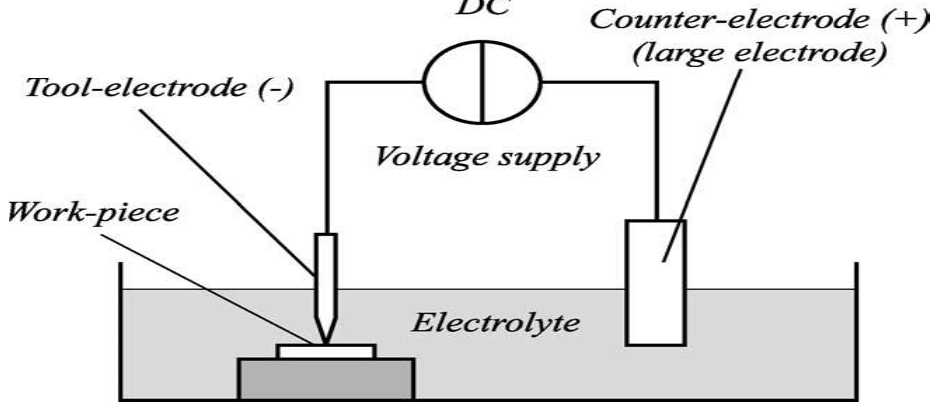
Figure 23. Basic cell configuration in electro-chemical discharge machining. Reproduced with permission from [162]. Table 4. Summary of EDM of Non-conductive ceramics.